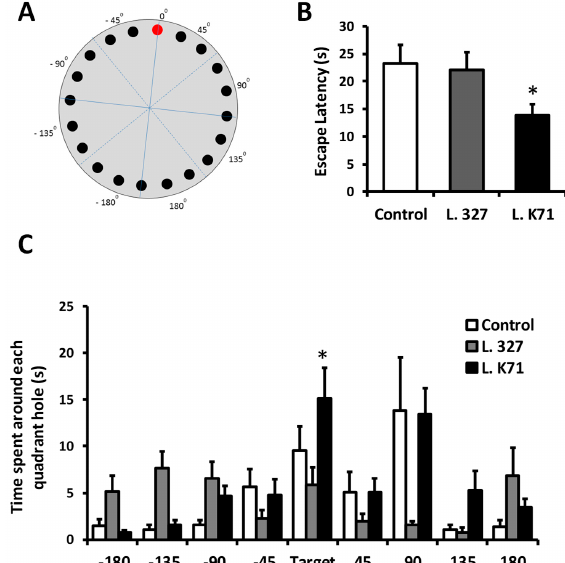
Figure 1. Effect of 43-week Lactobacillus strain administration on spatial learning and memory in senescence-accelerated prone 8 mice (SAMP8). ( A ) Barnes maze diagram used to interpret the data; ( B ) Escape latency during the probe test; ( C ) Time spent in each quadrant during the probe test. Data are presented as mean ± SEM; n = 10 mice per group; * p < 0.05 vs. the control